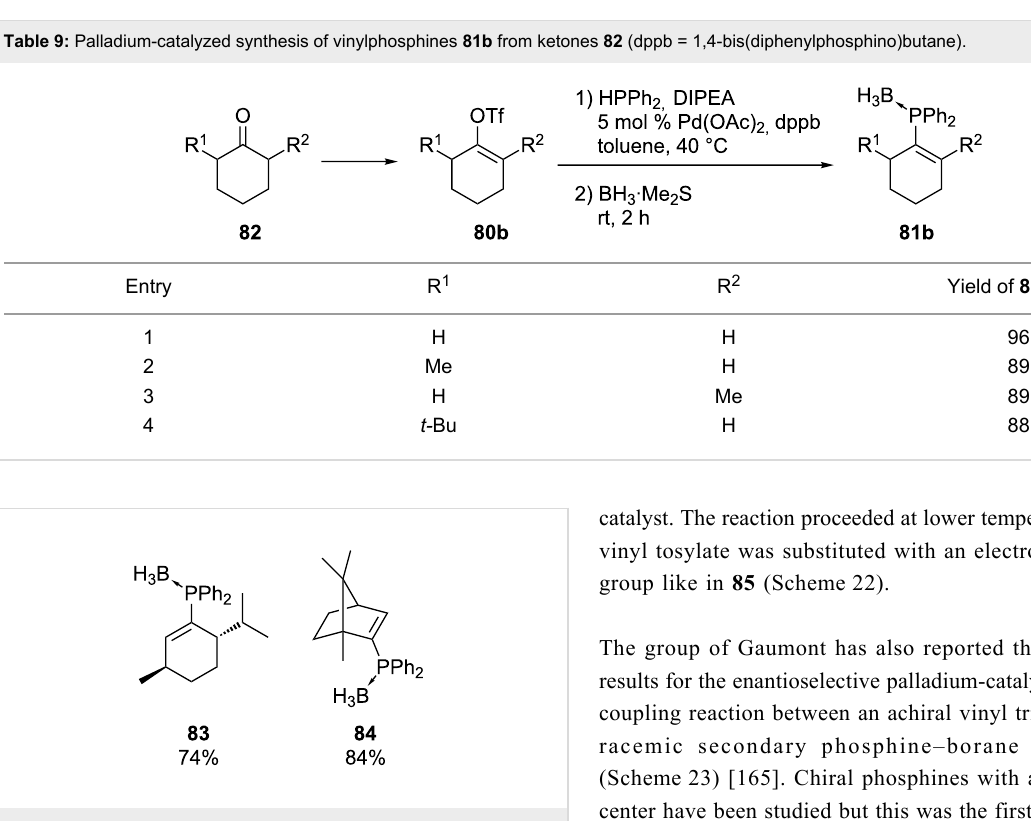
Figure 1: Menthone ( 83 ) and camphor ( 84 ) derived chiral phosphines.